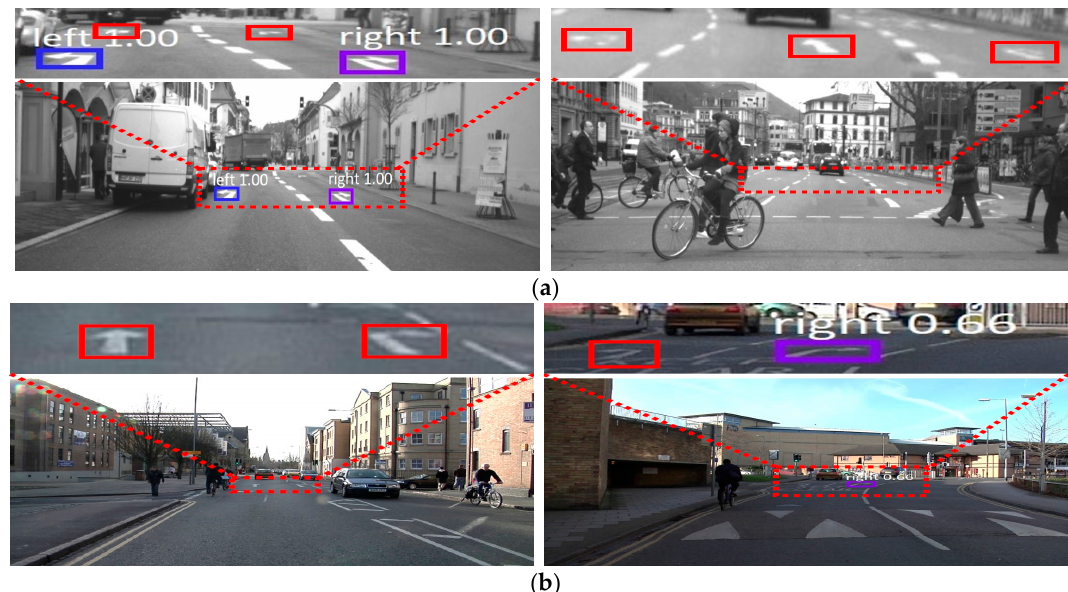
Figure 12. Examples of incorrect detection and classifications. ( a ) Test2 of the Daimler dataset. ( b ) Seq06R0 of the Cambridge dataset. In ( a , b ), the red colored boxes with solid lines indicate false negatives whereas the boxes of other colors represent true positives.